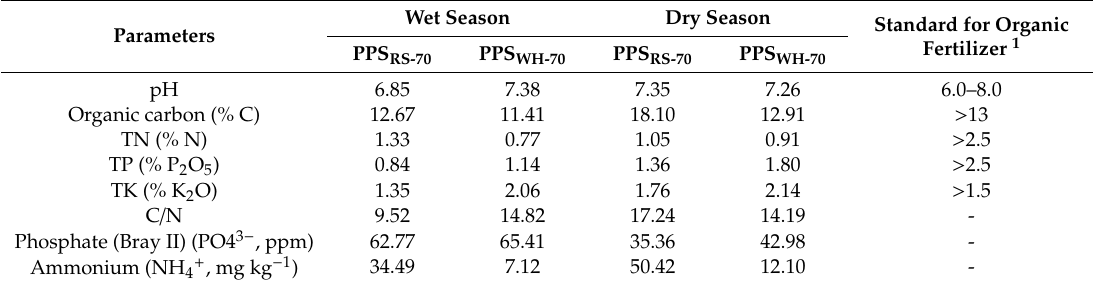
Table 3. Chemical composition of the organic fertilizers obtained from Pangasius pond sediments mixed with rice straw (PPS RS ) and with water hyacinth (PPS WH ) that were used in the wet and dry season cucumber cultivation, as well as the national standards for organic